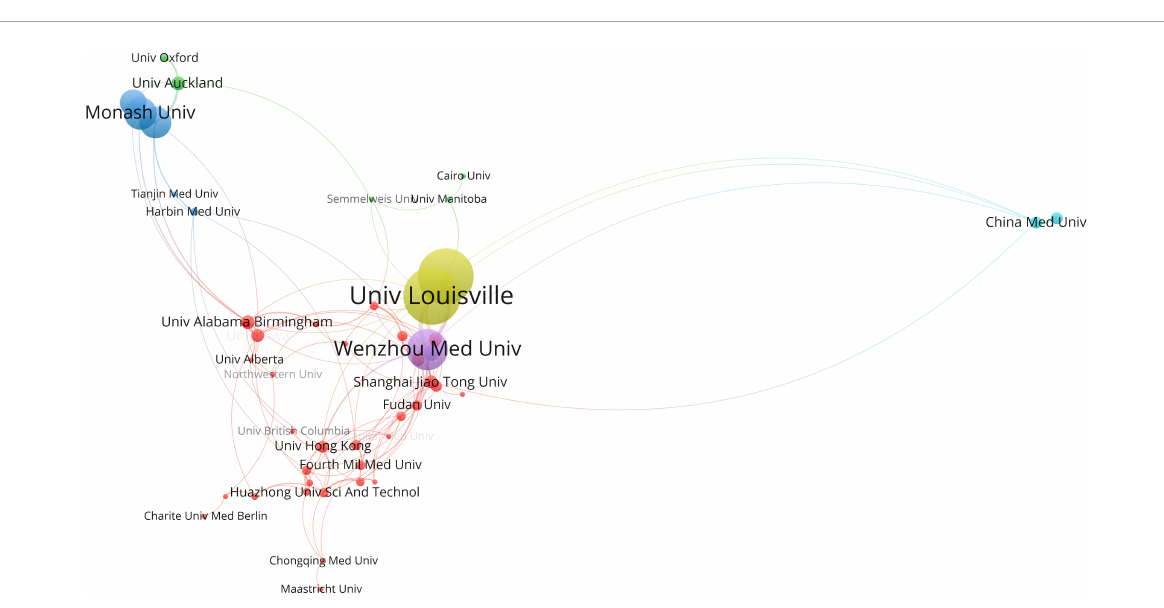
FIGURE4 Top 50 Institutions’ collaboration network map in the field of DCM ranked by